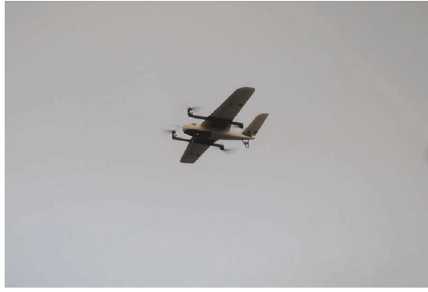
Figure 18: The DTR aircraft vertical flight